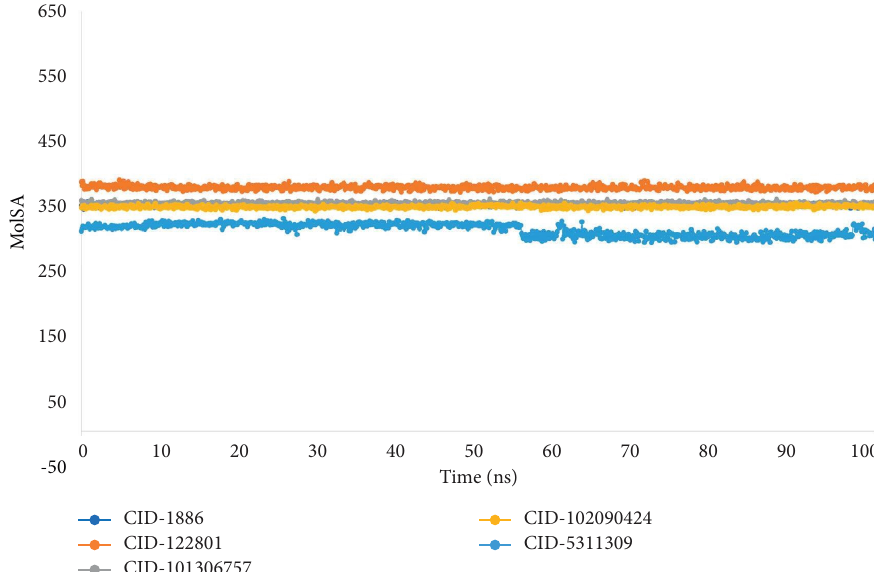
Figure 6: Te 100ns simulated interaction diagram was used to calculate the molecular surface area (MolSA) of the protein-ligand interaction complexes. Te markers blue, orange, gray, yellow, and light blue are used to depict the selected ligand compounds CID 1886,